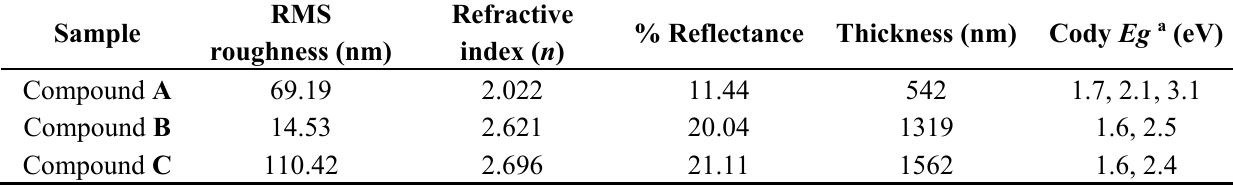
Table 2. Characteristic parameters of thin-films under investigation. RMS: root mean square.